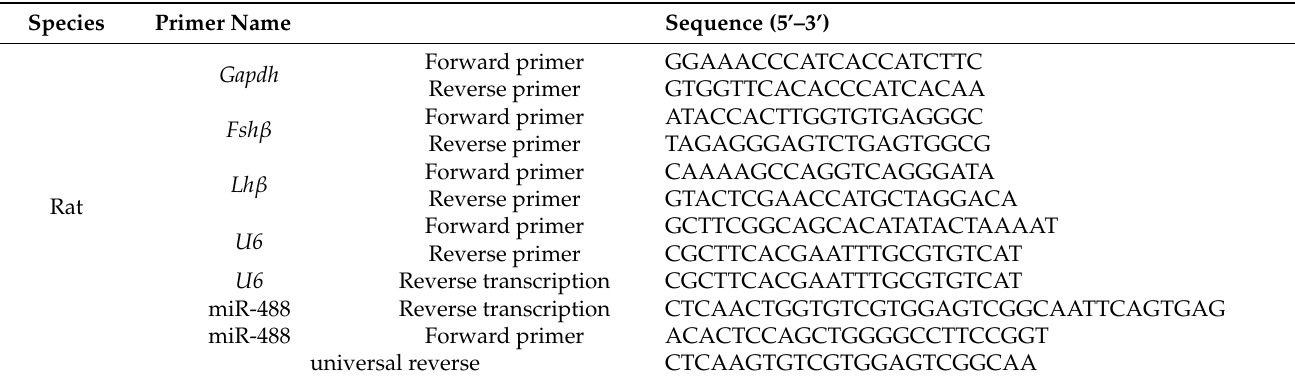
Table 1. Primers used for